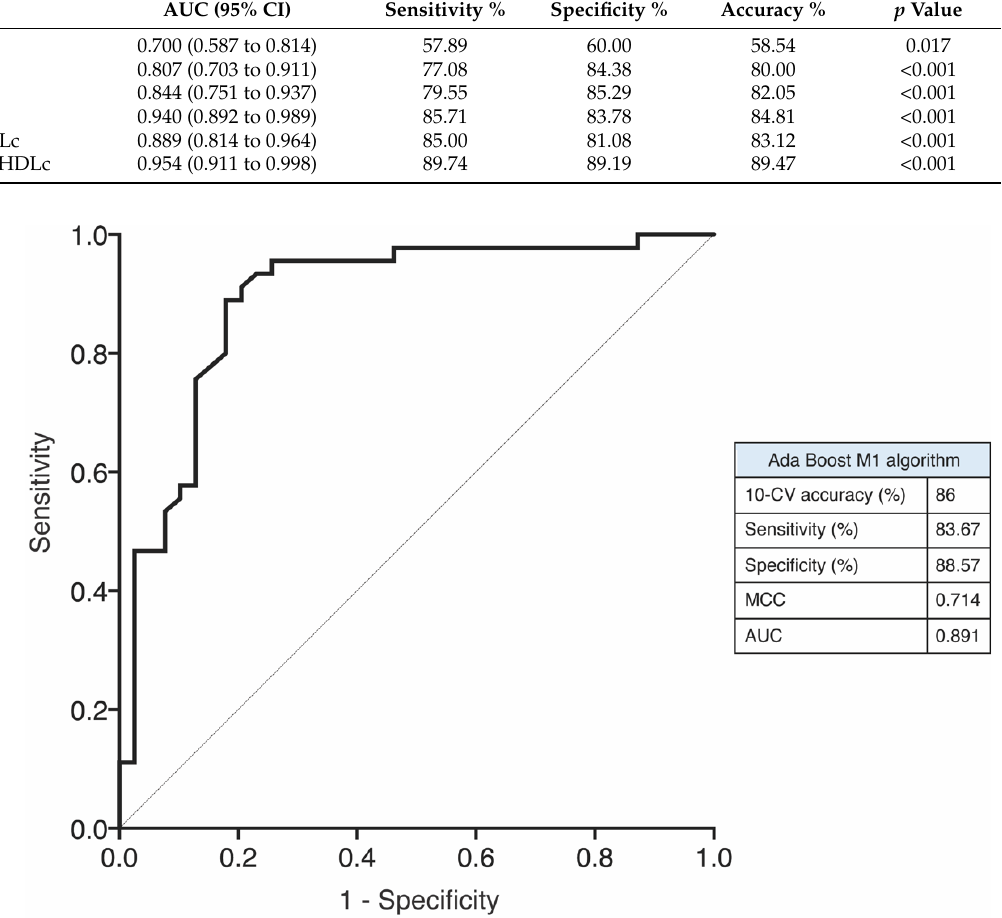
Figure 5. ROC curve of 10-fold cross validation test for 3-miRNA panel + DLP + non-HDLc model (Ada Boost M1).